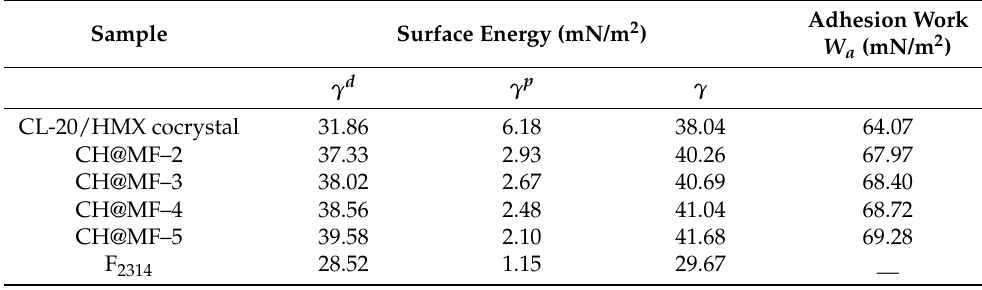
Table 3. Surface energies of the CL-20/HMX cocrystal, CH@MF composites and F 2314 together with